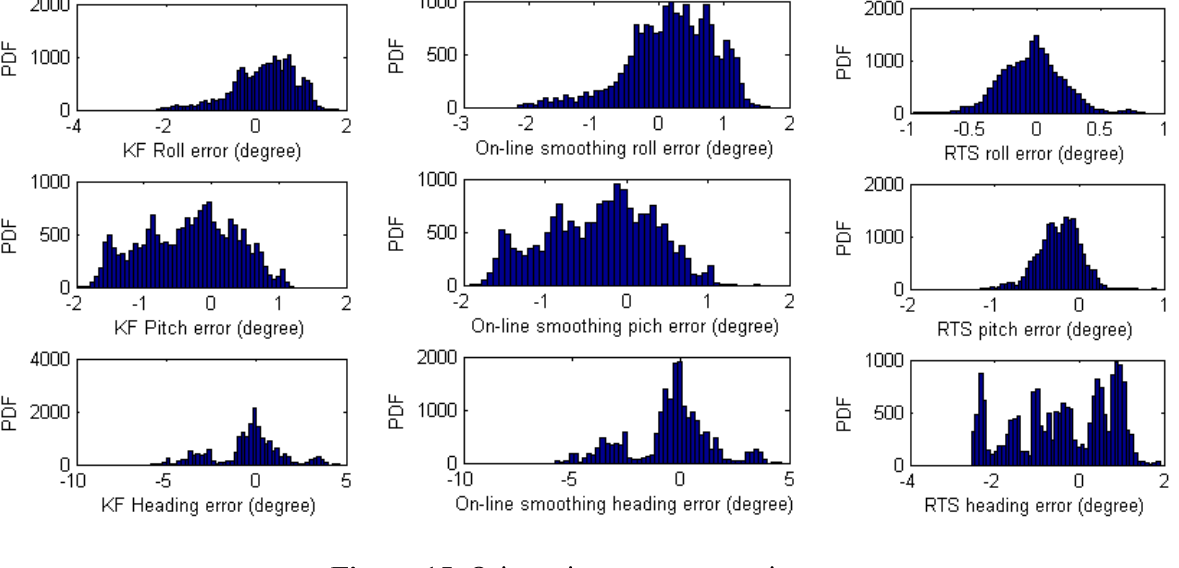
Figure 15. Orientation error